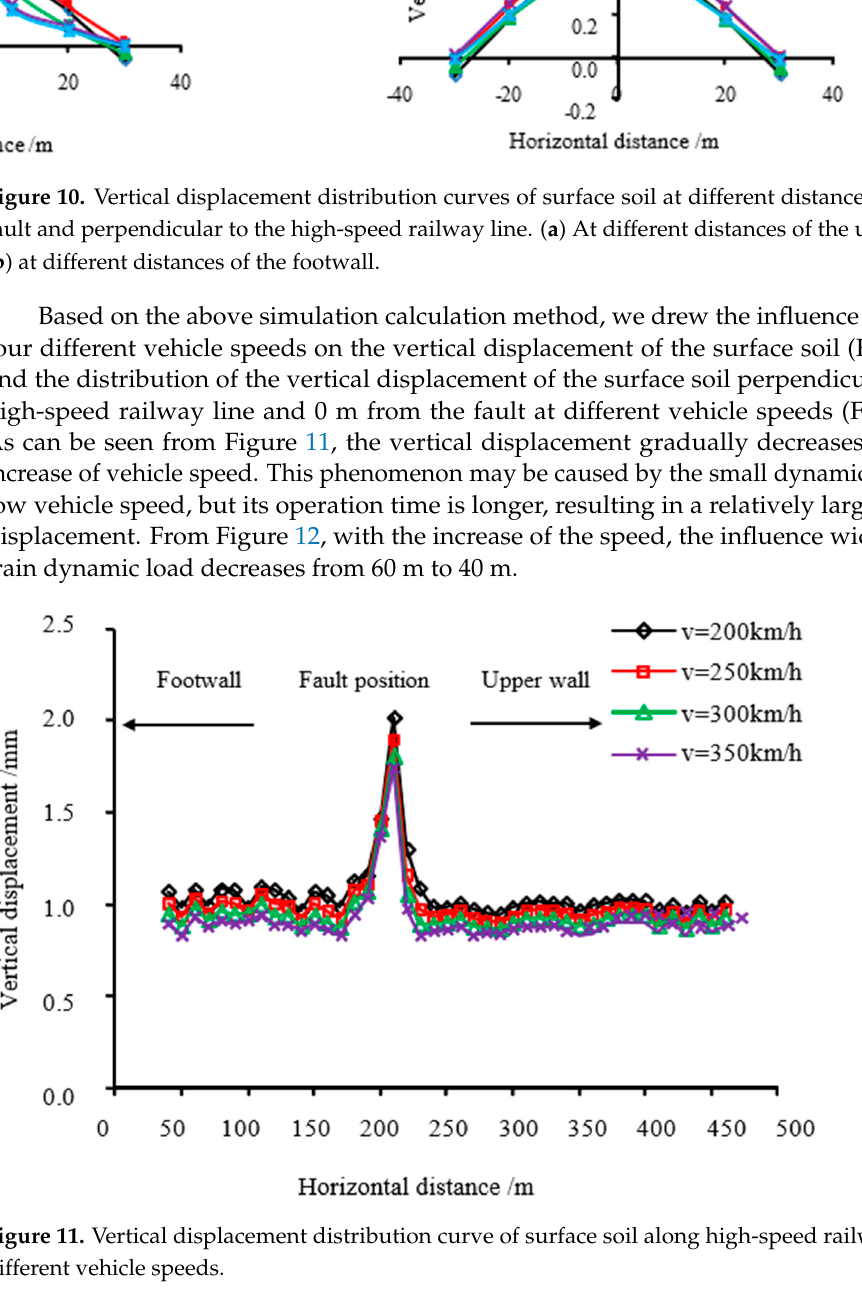
Figure 12. Vertical displacement distribution curves of surface soil at 0 m away from the fault and perpendicular to the high-speed railway line. ( a ) Upper wall 0 m away from the fault; ( b ) footwall 0 m away from the fault.